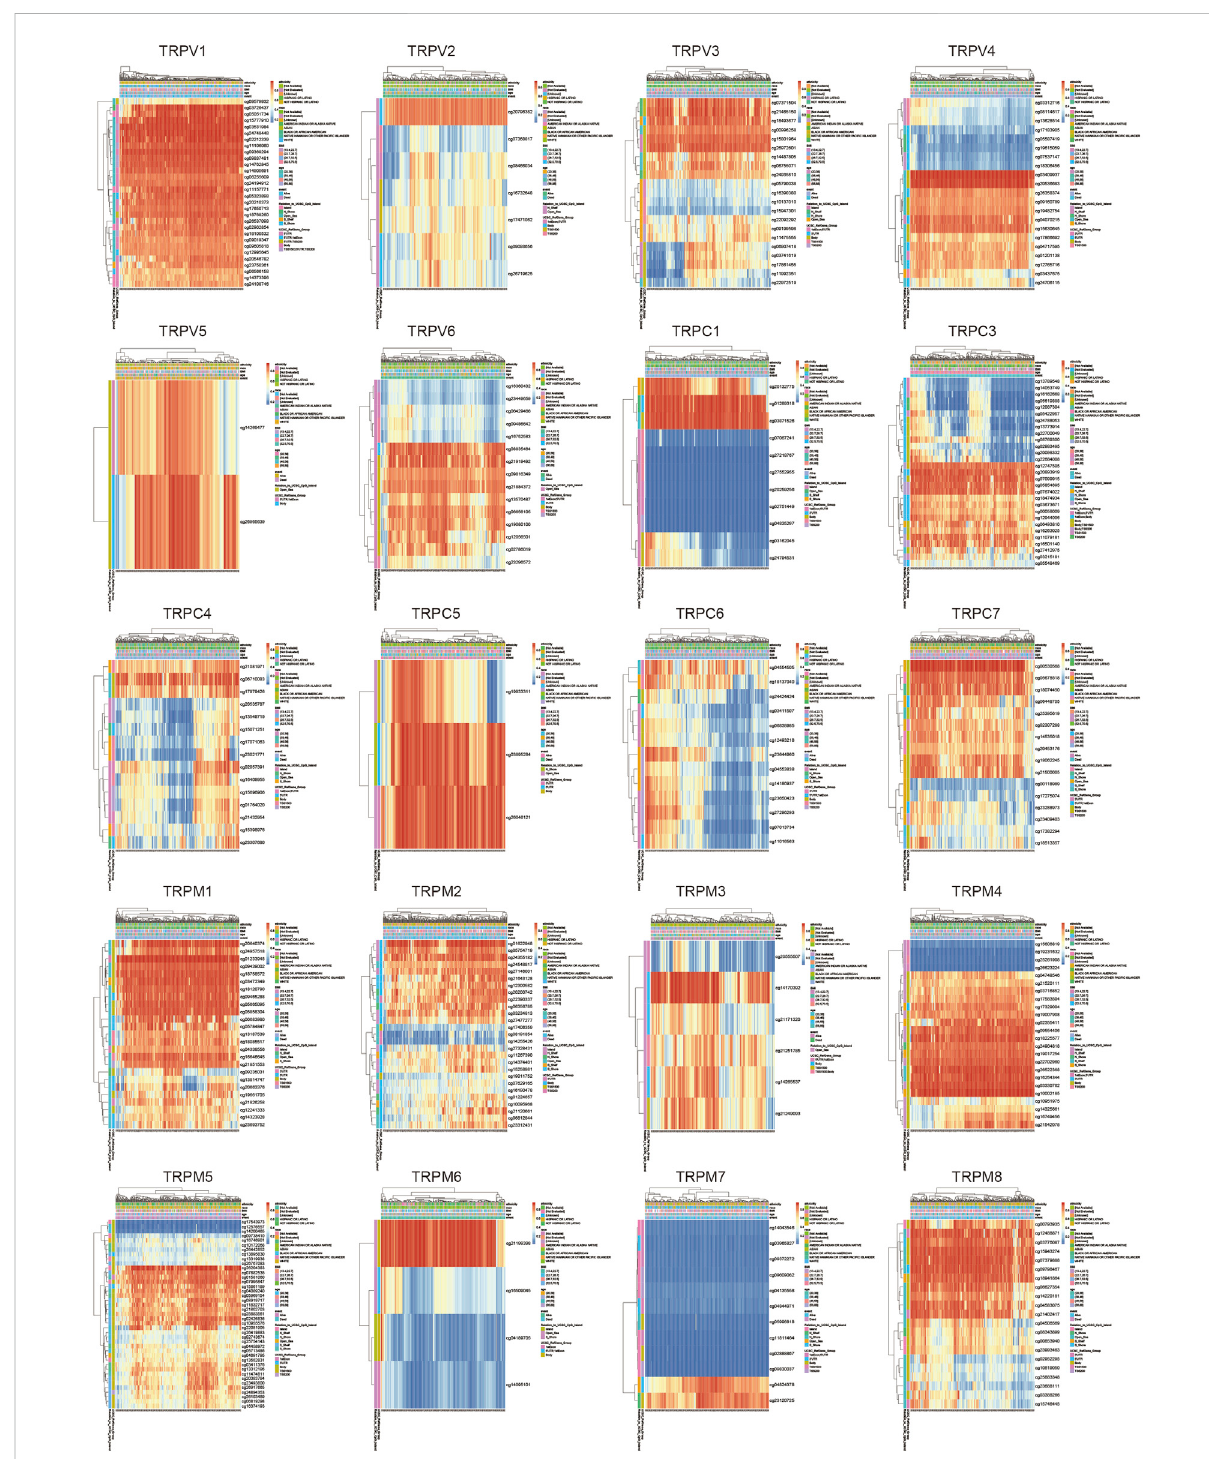
The prognostic value of the DNA methylation of TRPs signature in